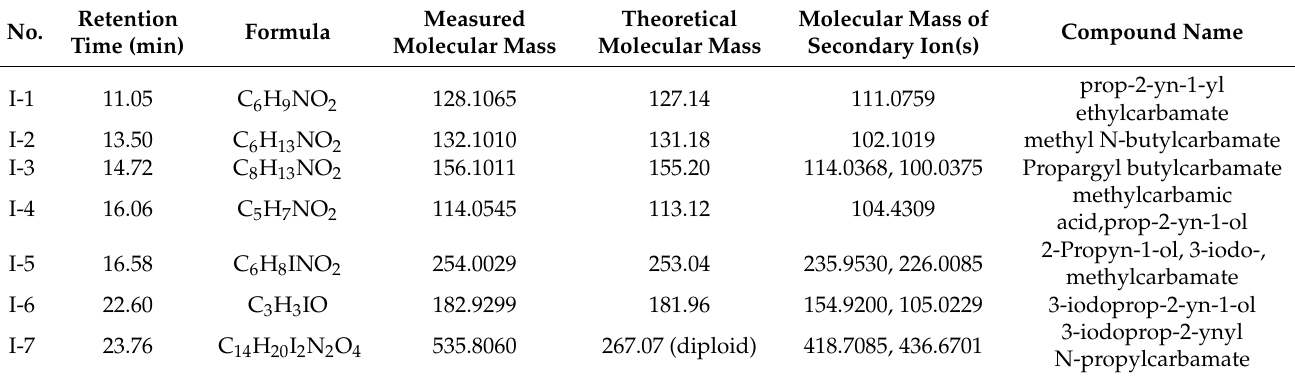
Figure 9. Mass spectrum of degradation products I2, I3, I4, and I6 of IPBC degradation: MS, ( a ); MS/MS, ( b ). Table 4. List of the products formed during the thermal degradation of